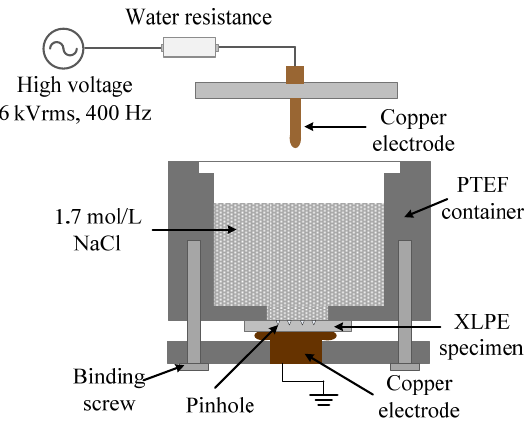
Figure 2. Water tree accelerated aging experimental setup